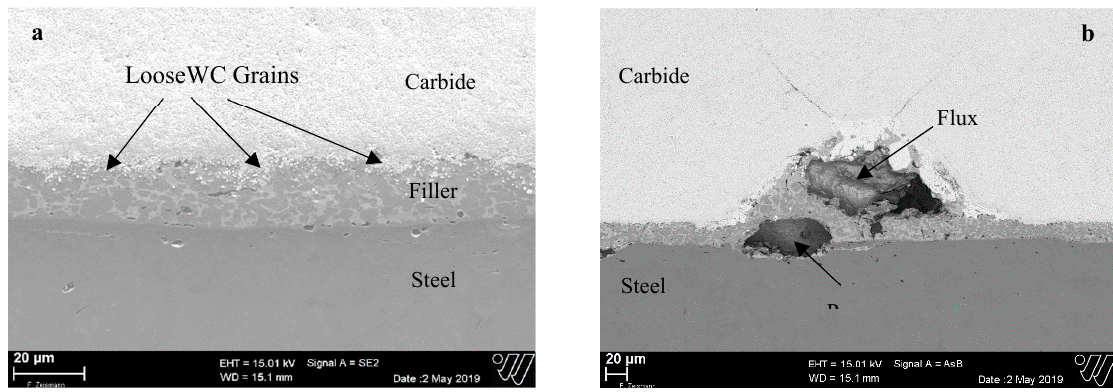
Figure 9. SEM micrograph of brazed sample with grid pattern on carbide showing ( a ) loose tungsten carbide (WC) grains at the filler / carbide interface ( b ) Porosity and remnant flux in the grooves.